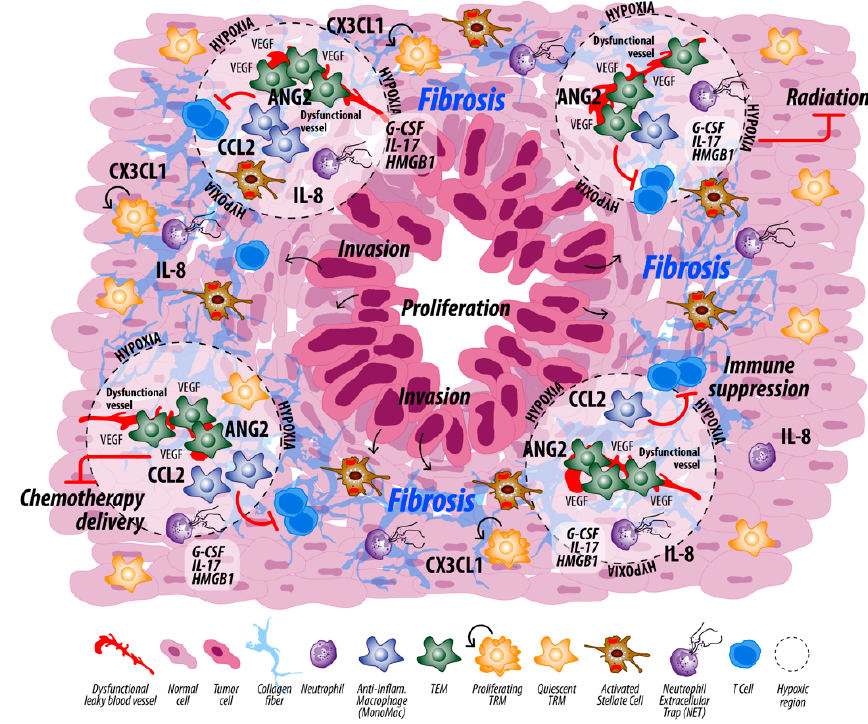
Figure 4. Recruitment of MonoMacs, TEMs, and neutrophils and proliferation of TRMs causes